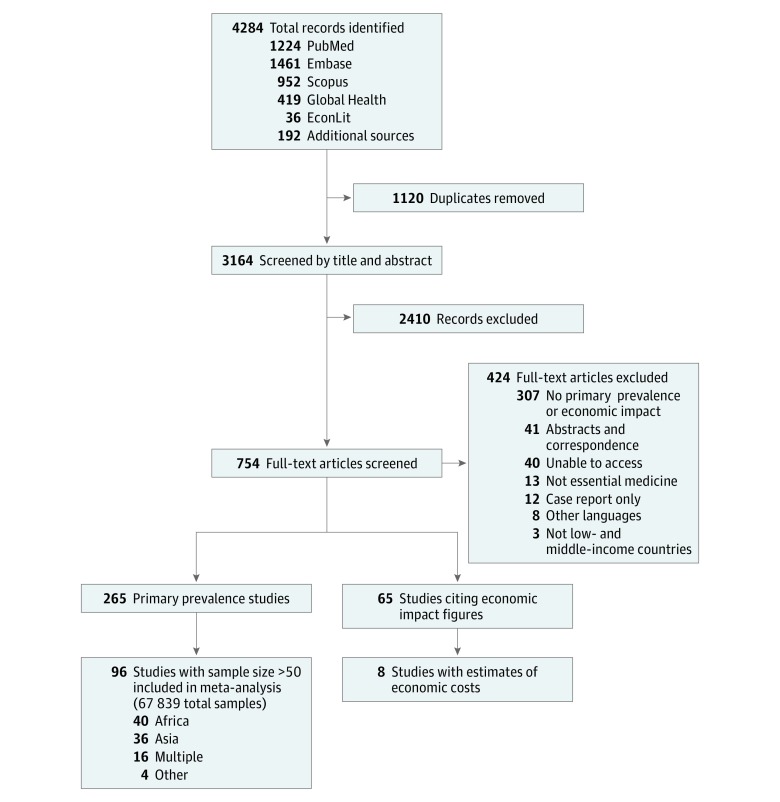
PRISMA Flowchart